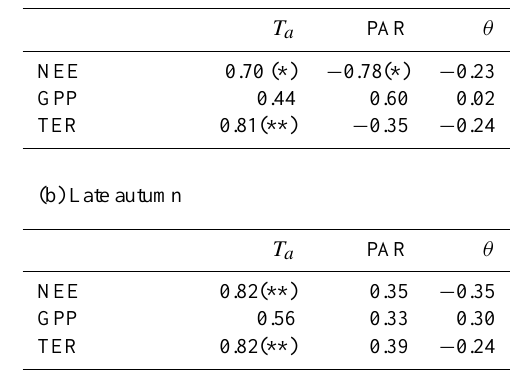
Table 2. Partial correlations (N=11) between cumulative carbon fluxes (NEE, GPP and TER) and air temperature ( T a ), photosyn- thetically active radiation (PAR) and volumetric soil moisture con- tent ( θ ). The partial correlations with respective environmental variable were calculated by controlling for the effects of the two other variables. Statistically significant correlations are marked with ** (2-tailed p < 0 . 01) and * (p < 0 .